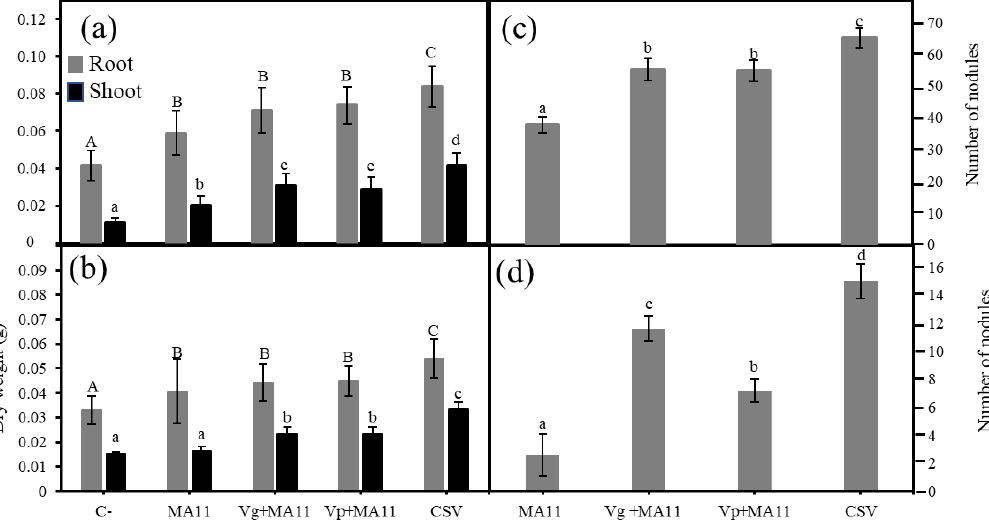
Figure 2. In vitro effects of M. sativa inoculation with Variovorax . ( a ) Dry weight of shoots and roots of M. sativa plants after 30 days in BNM plates; ( b ) dry weight of shoots and roots of M. sativa plants after 30 days in BNM plates supplemented with 30 μM As; ( c ) number of nodules in M. sativa plants after 30 days in BNM plates, ( d ) number of nodules on M. sativa plants after 30 days in BNM plates supplemented with 30 μM As. Values are means ± S.D. ( n = 5). Different letters indicate means that are significantly different from each other (one-way ANOVA; LSD test, p < 0.0001). C – : non inoculation; MA11: inoculation with Ensifer medicae MA11; Vg: inoculation with Variovorax gossypii JM-310 T ; Vp: inoculation with V. paradoxus S110 T ; Vg + MA11: co-inoculation with V. gossypii JM-310 T and E. medicae MA11; Vp + MA11: co-inoculation with V. paradoxus S110 T and E. medicae MA11; CSV: inoculation with V. gossypii JM-310 T , V. paradoxus S110 T , and E. medicae